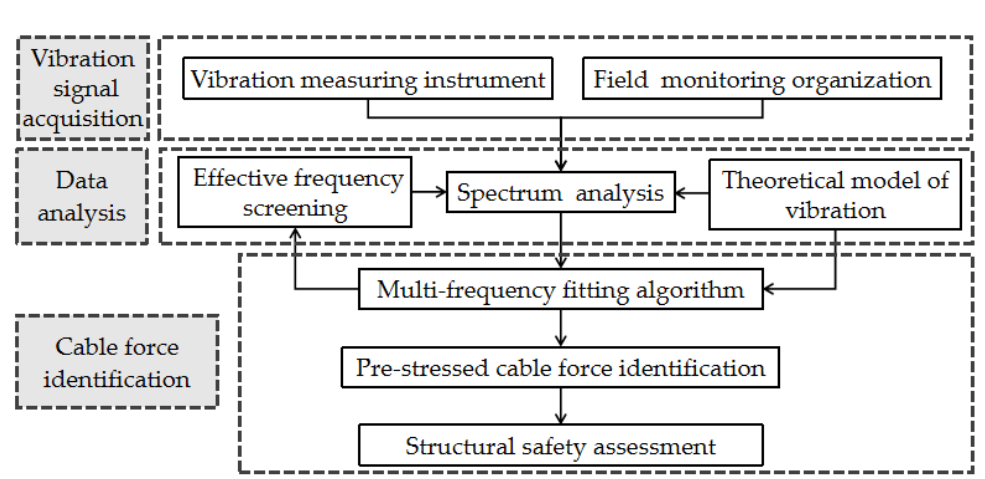
Table 5. Results of frequency detection and multi-frequency fitting cable force optimization of a bidirectional string structure.